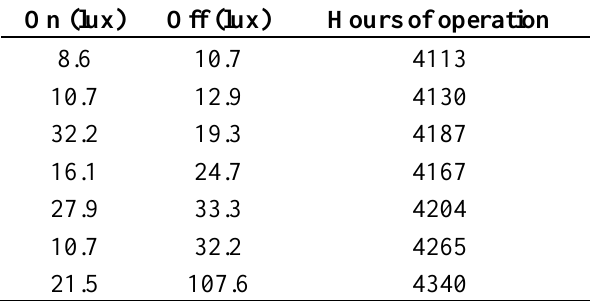
Table 9. Hours of operation regarding the twilight settings [39].